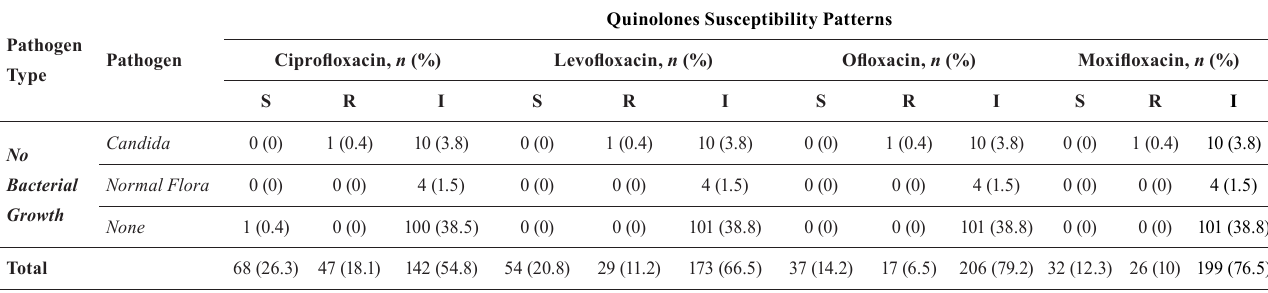
TABLE V - Q uinolones Susceptibility Patterns against Respiratory Tract Pathogens